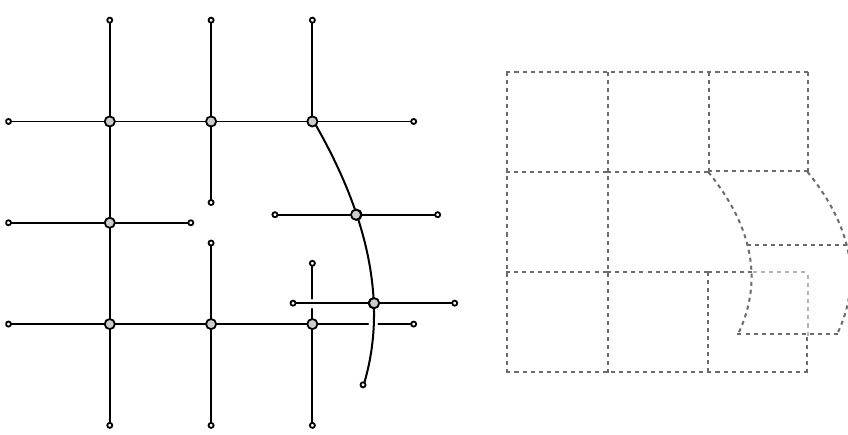
Figure 3 . Correlator diagram and its dual (without external legs), which cannot be cut out of a simple sheet of regular square lattice. However, it can be cut out of a \double-sheet" regular square lattice with a branchpoint. More general graphs can be cut out of the lattices having various \conical" singularities, see footnote